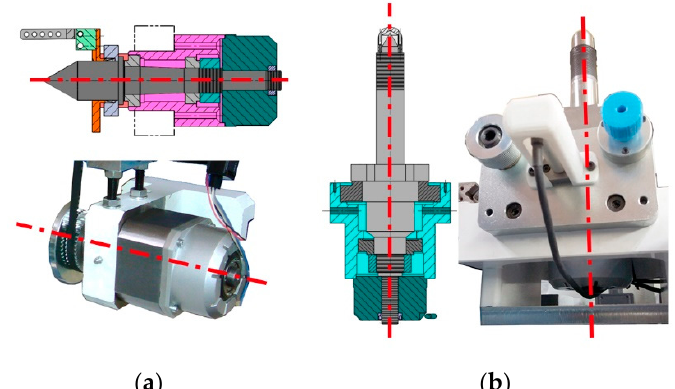
Figure 15. Angular positioning error measurement: ( a ) design detail of the angular encoder alignment with worm rotation axis (B-axis); ( b ) design detail of the angular encoder alignment with worm gear rotation axis (C1-axis).